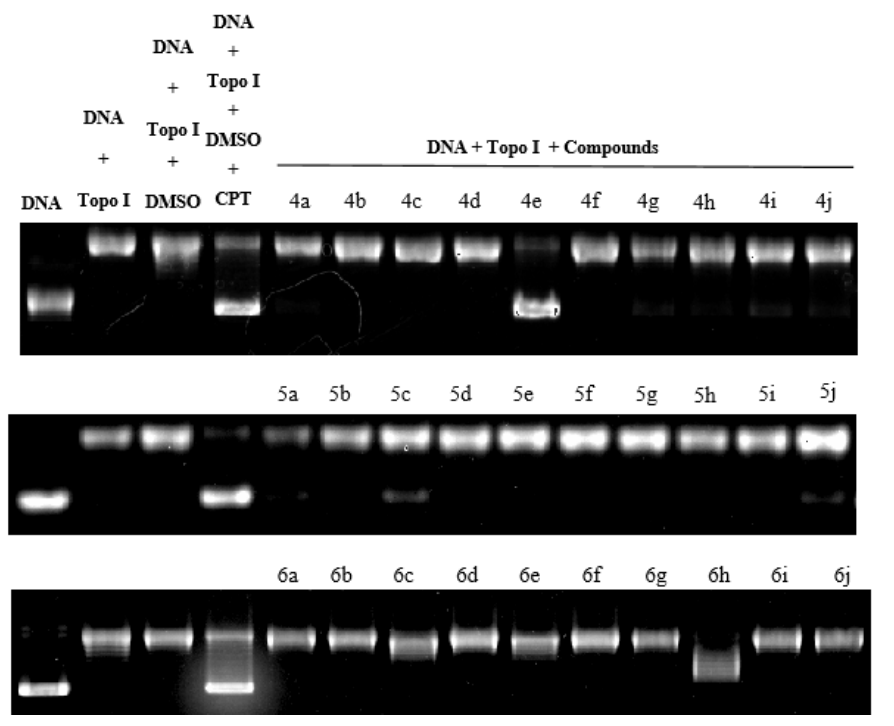
Figure 9. DNA topoisomerase I (Topo I) inhibitory activity of CPT and all target compounds ( 4a – 4j,